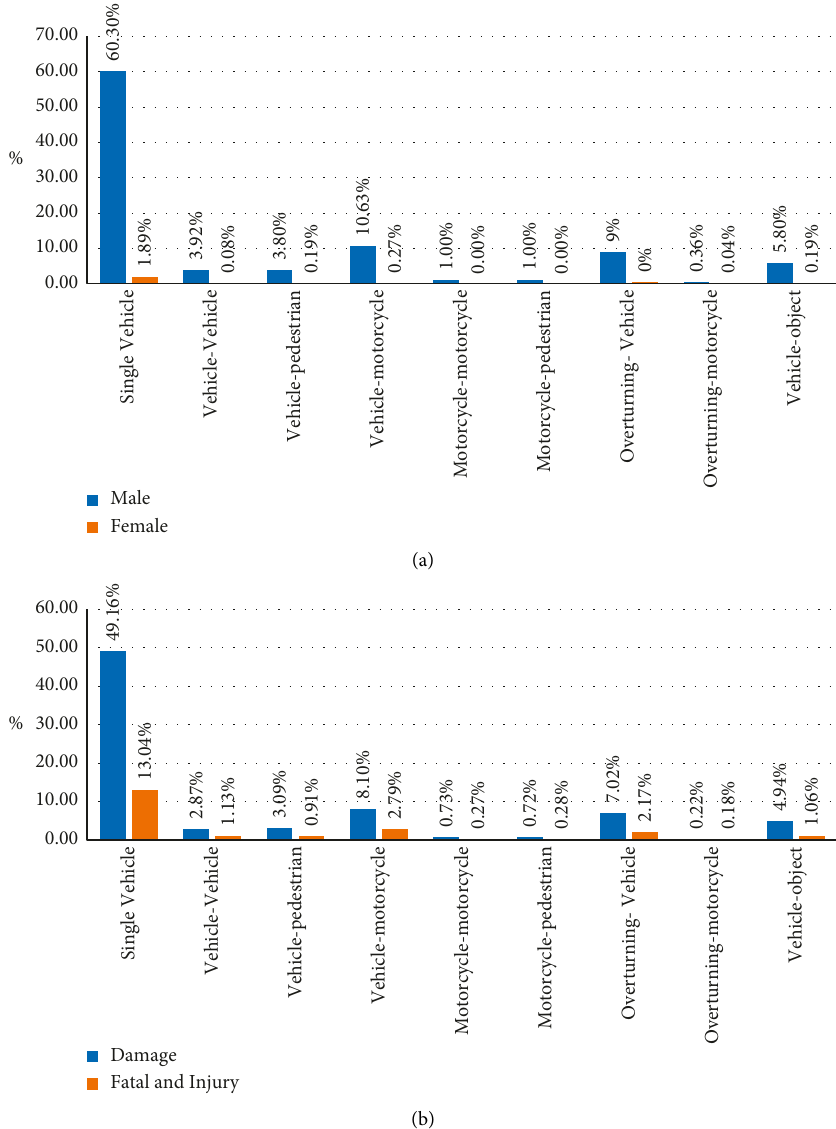
Figure 3: Statistics of vehicle accidents based on collision type: (a) gender of the driver and (b) severity of accidents.